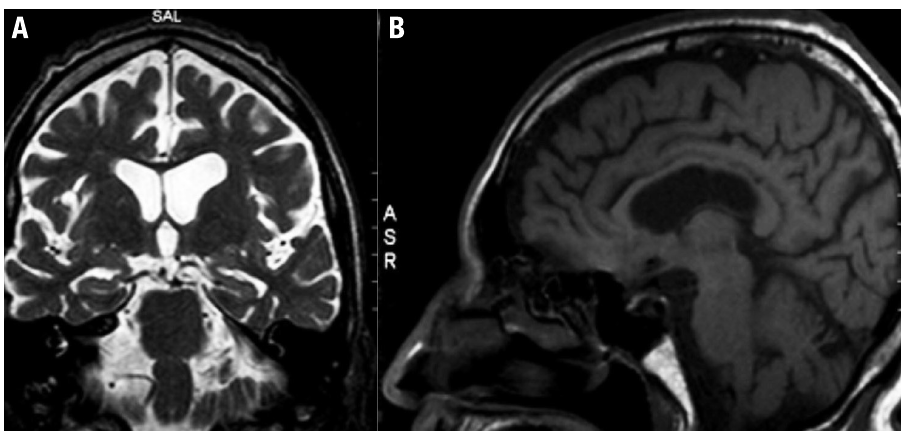
Figure 3. Brain MRI showing: [A] (T2-weighted coronal section) mild hippocampal atrophy; [B] (sagittal T1 section) posterior callosum